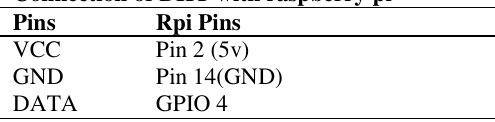
Connection of DHT with raspberry pi